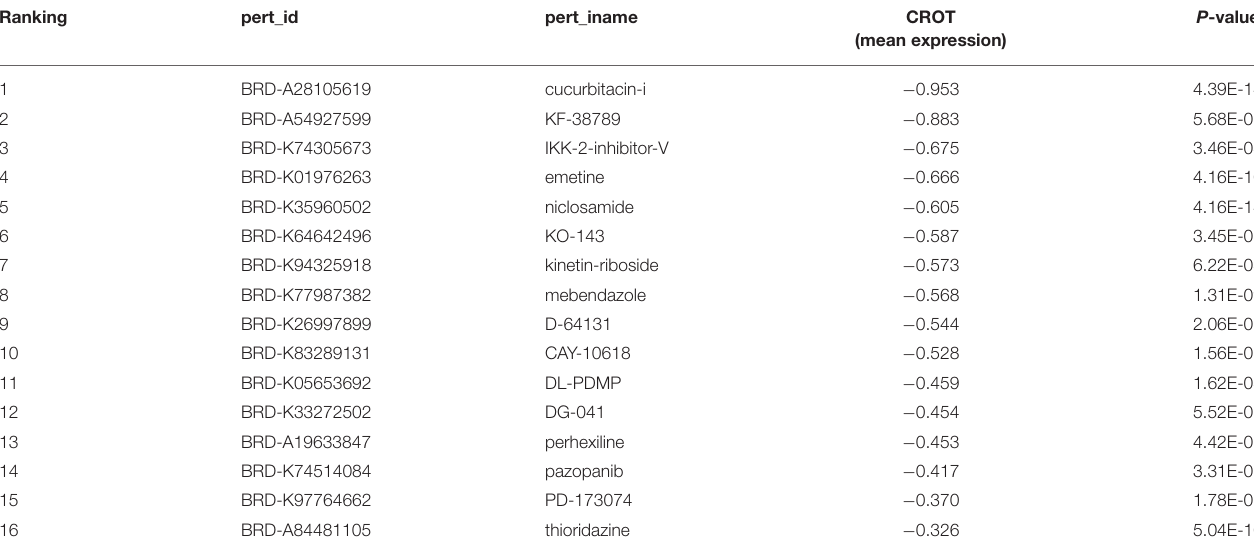
TABLE 1 | Candidate small molecules that possibly decrease CROT expression.